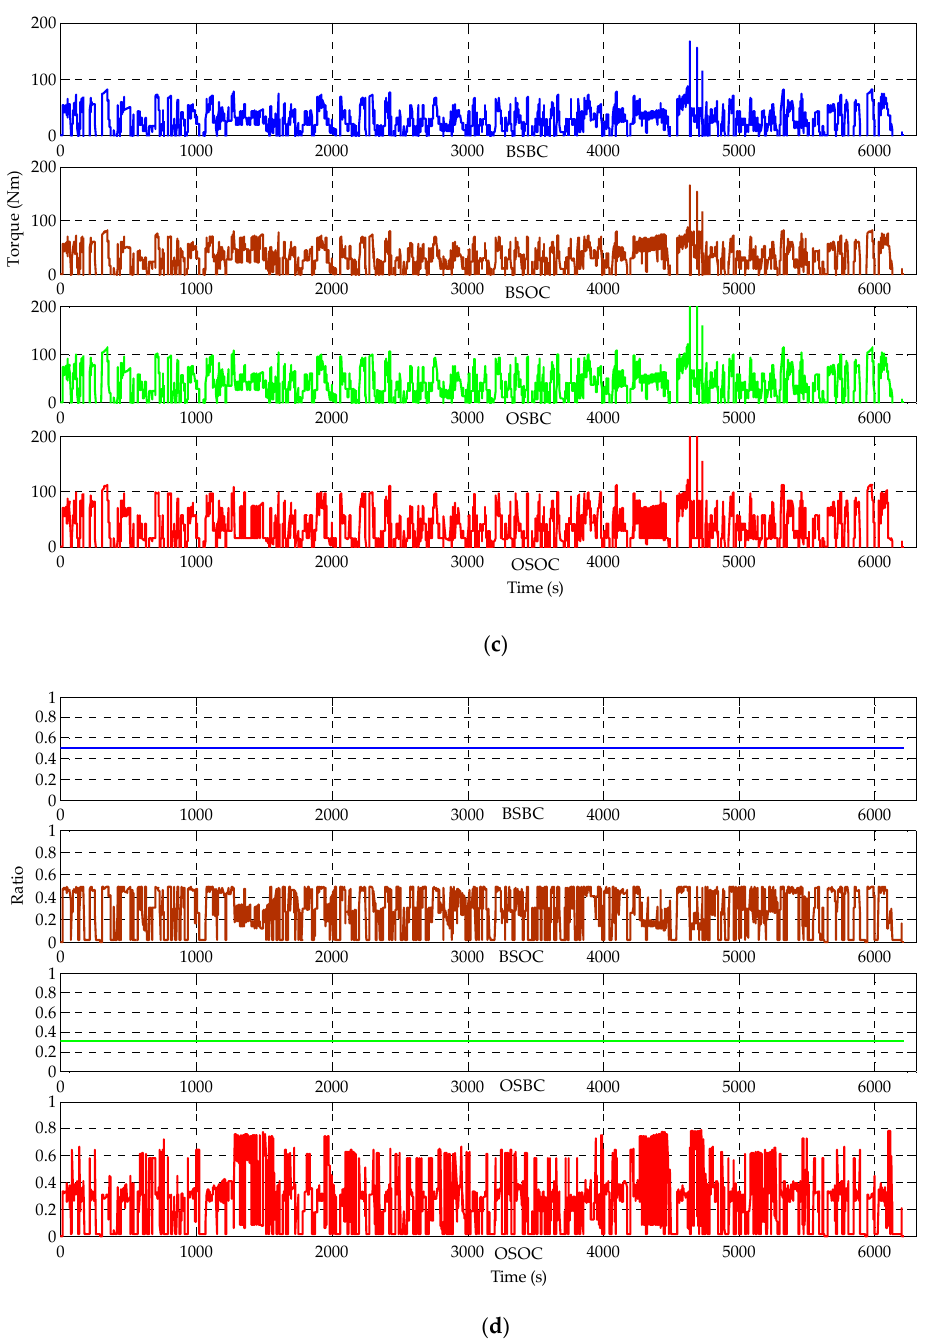
Figure 13. Demand speed and torque distribution of the front and rear wheel motors under the constructed driving cycle. ( a ) Driving cycle; ( b ) the torque distribution of the front-axle motors; ( c ) the torque distribution of the rear-axle motors; ( d ) the distribution ratio of the front-axle motors.